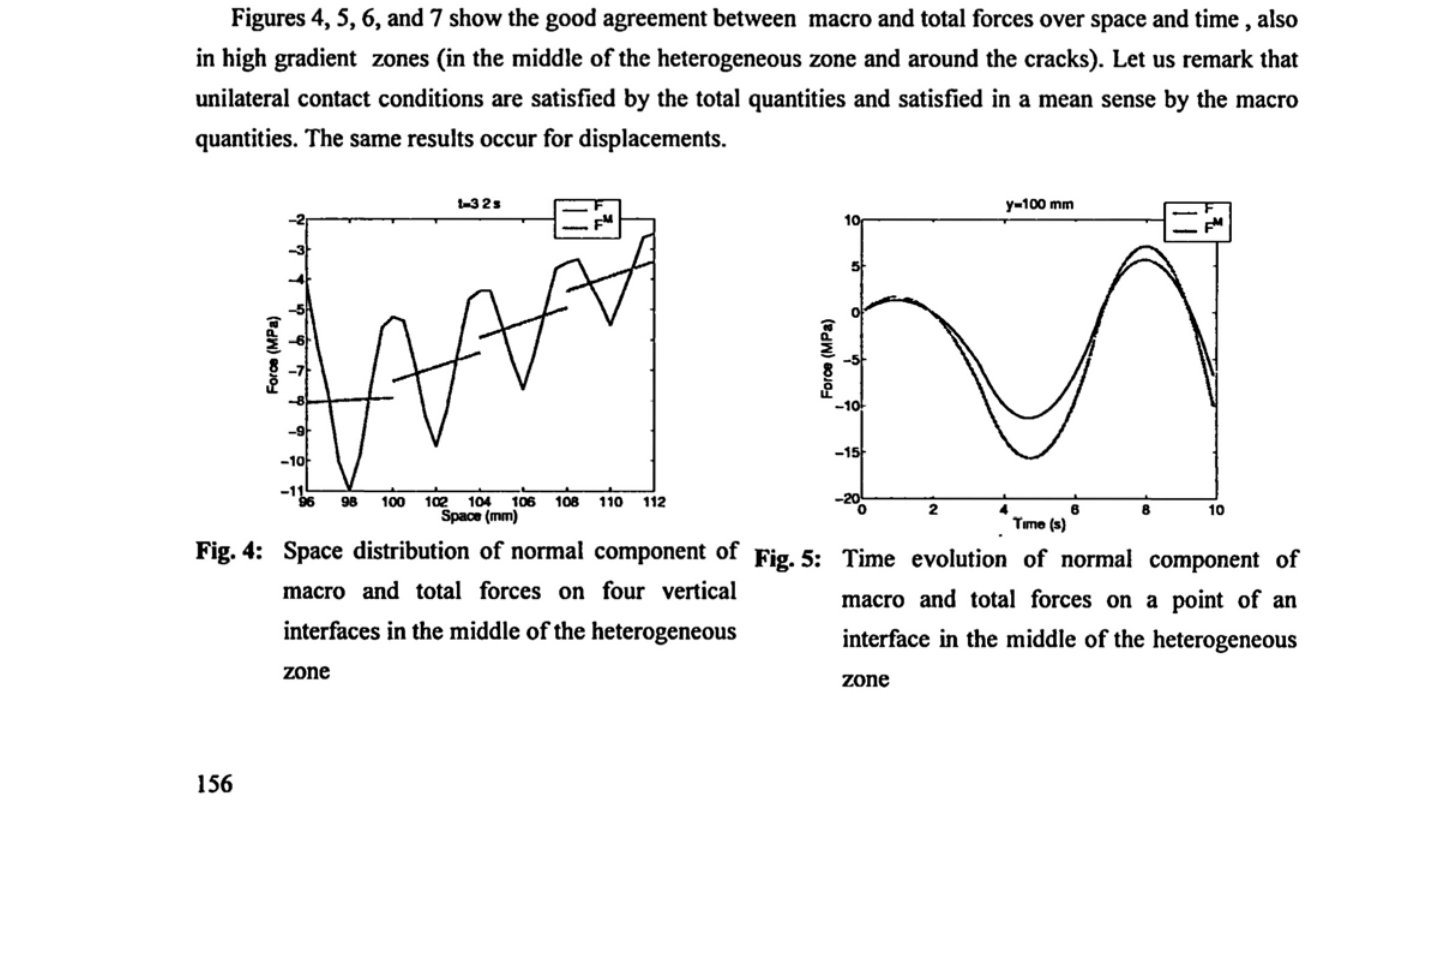
Fig. 4: Space distribution of normal component of macro and total forces on four vertical